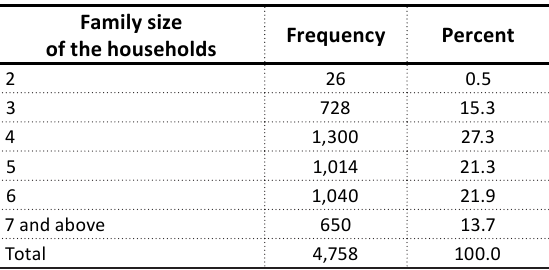
Table 6. Family size of households